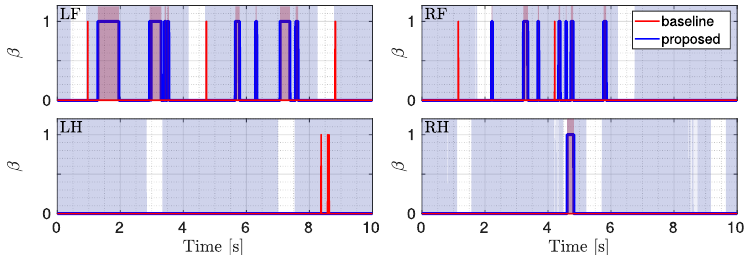
Figure 13. Comparison between the flags. The red one is obtained with the baseline approach, the blue one with the proposed approach. The gray shaded area shows stance phases and the red shaded area indicate the ground